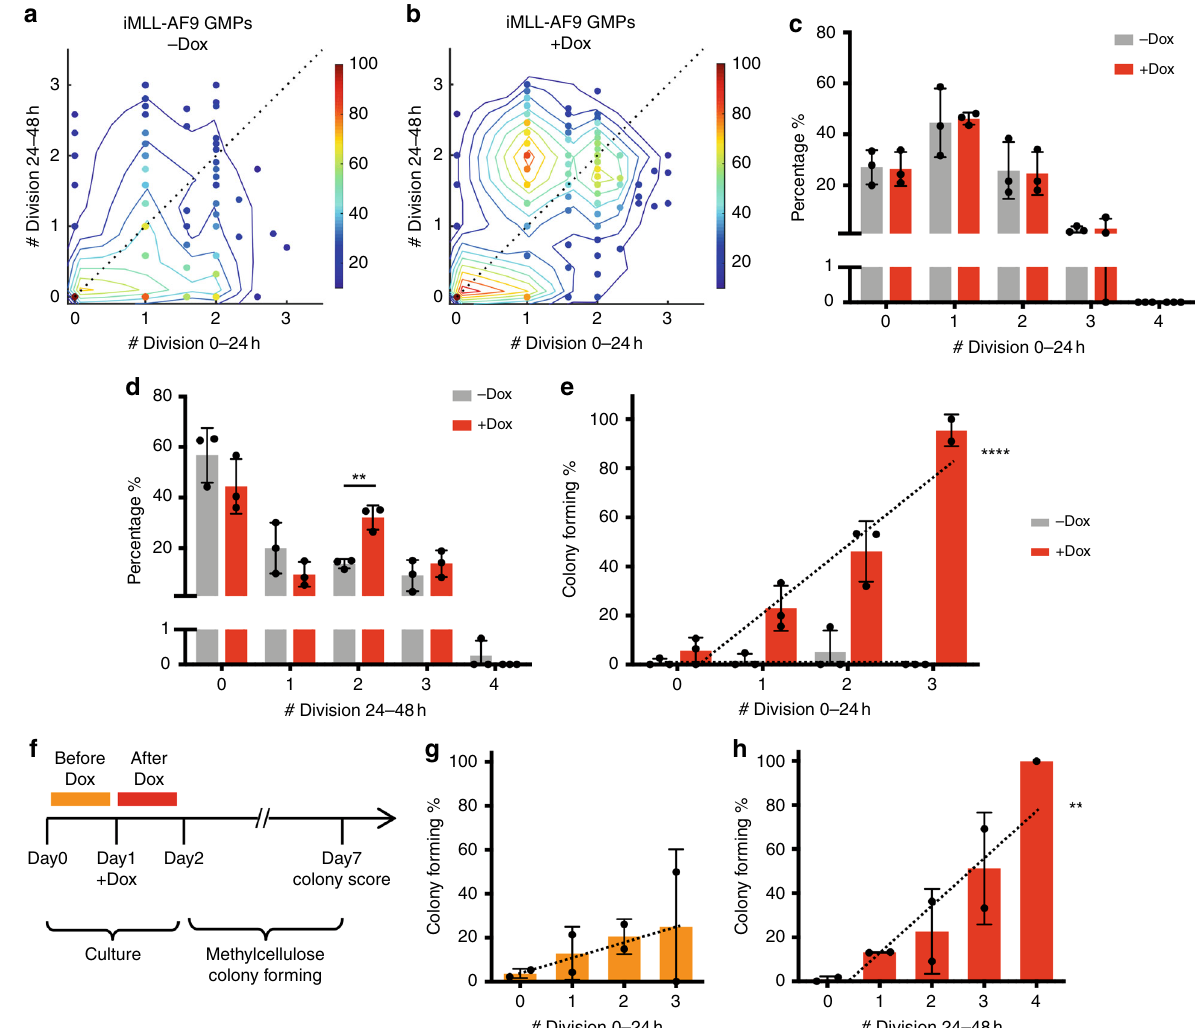
Fig. 2 MLL-AF9-mediated transformation ef fi ciency is associated with the intrinsic cycling rate of GMPs. a , b Cell cycle rates of individual iMLL-AF9 GMP lineages. The presence of single GMP was con fi rmed at 0 h, and plotted as individual dots. a − Dox: n = 268; b + Dox: n = 378 (Dox was added at 0 h). The number of divisions during 0 – 24 h ( x -axis) = Log2(cell number at 24 h/cell number at 0 h); the number of divisions during 24 – 48 h ( y -axis) = Log2 (cell number at 48 h/cell number at 24 h). Pseudo color denotes GMP lineage density, with the highest observed density in each sample normalized to 100. Dotted diagonal line denotes y = x . In the presence of Dox, signi fi cant number of GMP lineages underwent cell cycle acceleration, shown as the dense population above the diagonal line. c Cell cycle rate distribution during 0 – 24 h of iMLL-AF9 GMP culture + / − Dox. Cell cycle rates were determined as described in a , b , and rounded up to the nearest integer. Detailed measurements are shown in Supplementary Table 1; n = 3 for + / − Dox measurements. No signi fi cant difference was observed between + / − Dox conditions. d Similar analysis as in c performed for 24 – 48 h of culture; n = 3 for + / − Dox measurements. p = 0.0036 for two divisions, as calculated by unpaired t -test. e Single-cell colony-forming ef fi ciency by iMLL-AF9 GMPs of different cycling rates as de fi ned by number of cell divisions during 0 – 24 h in vitro culture. Dotted lines represent linear regressions; n = 3 for + / − Dox. For + Dox condition, y = 28.06 × − 0.4914, p < 0.0001; for − Dox condition, y = 0.08382 × + 1.778, p = 0.9466. f Schematic timeline for measuring colony-forming ef fi ciencies in relation to cell cycle rates before and after Dox addition. Orange bars denote the time before Dox addition and the red bars denote the time after Dox addition. g Single-cell colony-forming ef fi ciency in iMLL-AF9 GMPs of different cycling rates prior to Dox induction, as shown in orange in f ; n = 2. Dotted line represents linear regression: y = 7.140 × + 4.852, p = 0.1998. h Single-cell colony-forming ef fi ciency in iMLL-AF9 GMPs of different cycling rates following Dox induction, as shown in red in f ; n = 2. Dotted line represents linear regression: y = 21.47× − 7.473, p = 0.0016. Results are presented as mean±s.d. p value for linear regression was calculated by F- test to assess whether the slope is signi fi cantly